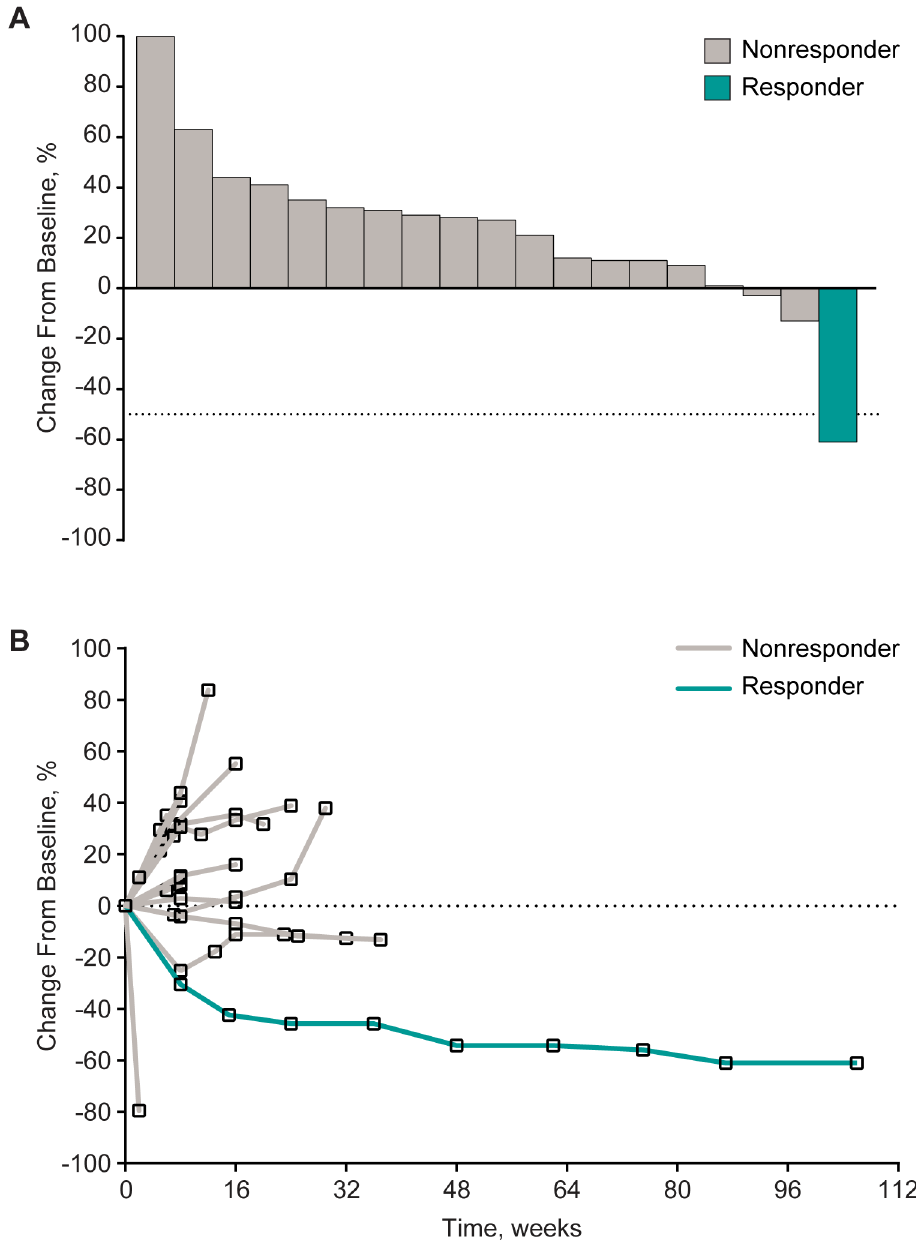
Fig 3. Change from baseline in tumor size. (A) Maximum change from baseline.(B) Longitudinalchange from baseline.Bothpanelsincludepatients with (cid:21) 1 evaluable postbaseline tumor assessment per Response Evaluation Criteria in Solid Tumors version 1.1 by investigatorreview ( n =